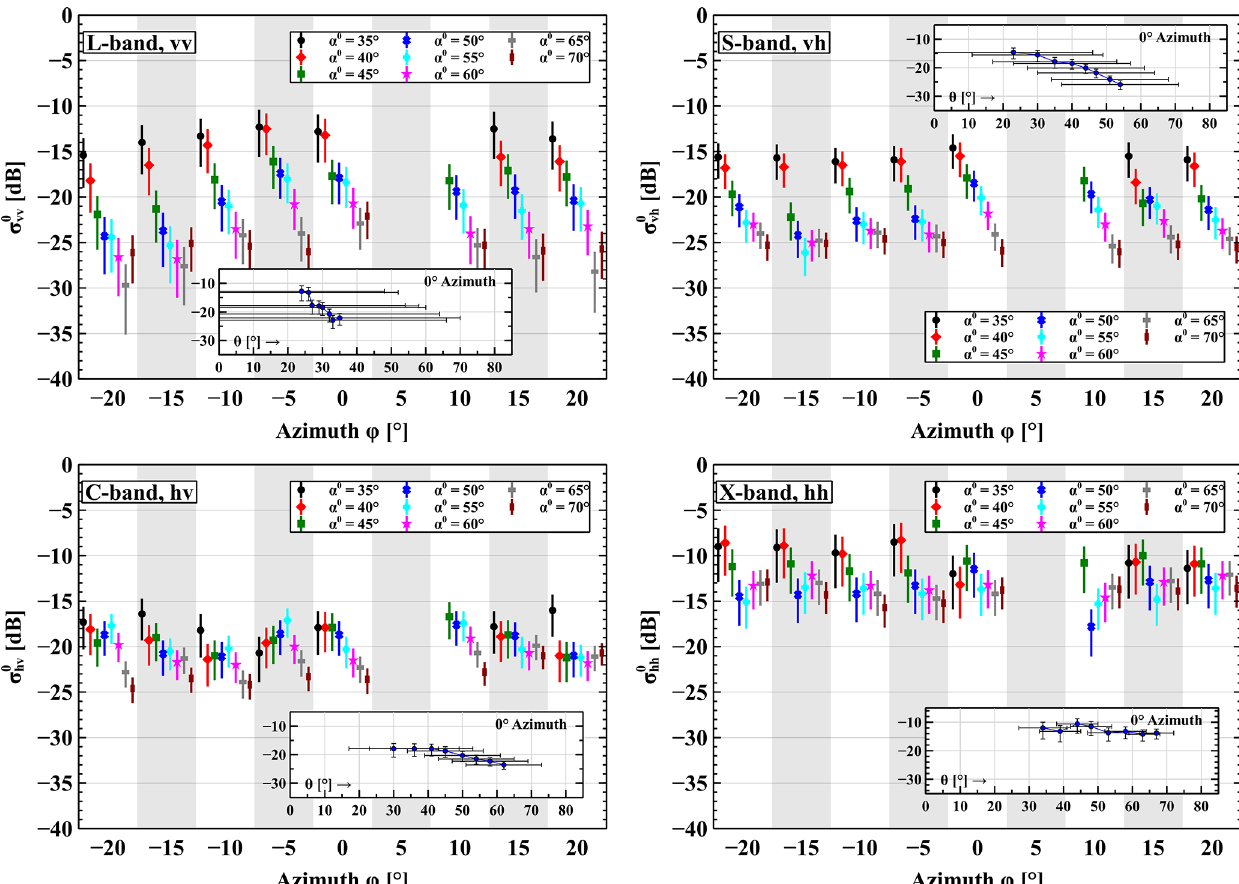
Figure G1. Measurement of σ 0 pq ( α 0 ,φ ) for all bandwidths at different polarization over the Maqu site on 25 August 2017. Four main figures: for different antenna boresight azimuth angles φ , the variation of σ 0 pq over boresight elevation angles α 0 is shown. The eight vertical bars represent the 66% confidence interval for σ 0 . Intervals for incidence angles θ per measurement are not shown here for figure clarity. Insets: σ 0 pq ( α 0 ) for φ = 0 ◦ . Horizontal bars represent intervals of actual incidence angles θ , which are identical for other φ values in the main